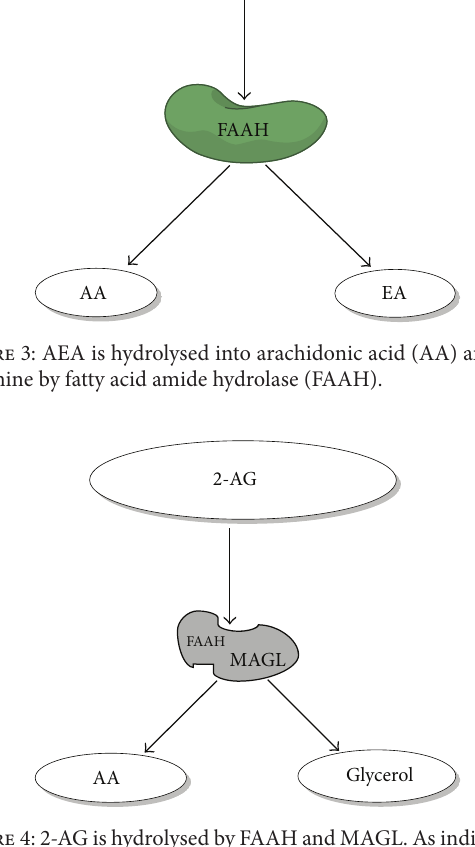
Figure 4: 2-AG is hydrolysed by FAAH and MAGL. As indicated by the size of the letters, MAGL is the major enzyme degrading